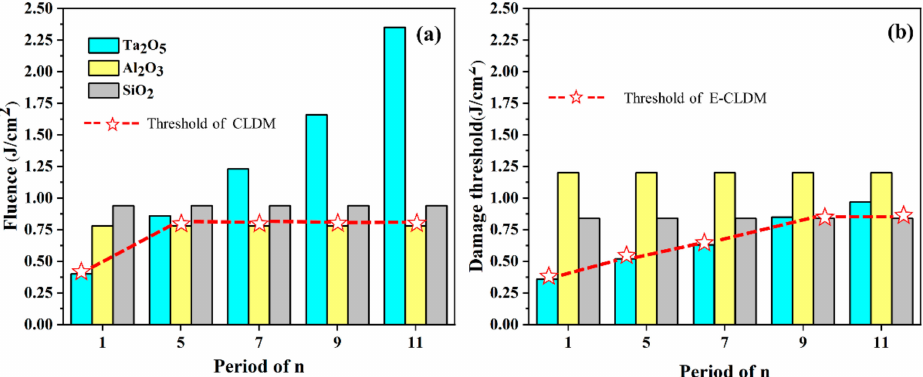
Figure 8. ( a ) Theoretical damage thresholds for all layer materials of CLDM with different protective layer periods. The threshold in Ta 2 O 5 increases with the number of Al 2 O 3 periods and the actual threshold of CLDM has the lowest threshold value for layer materials. n = 5 is an inflection point. n < 5, the damage threshold of E-CLDM increases with the n increasing; n > 5, the threshold of CLDM remains unchanged. ( b ) Theoretical damage thresholds for all layer materials of E-CLDM with different protective layer periods. n = 9 is an inflection point. n < 9, the damage source is in Ta 2 O 5 . n > 9, the damage source is in SiO 2 and the threshold of E-CLDM keep